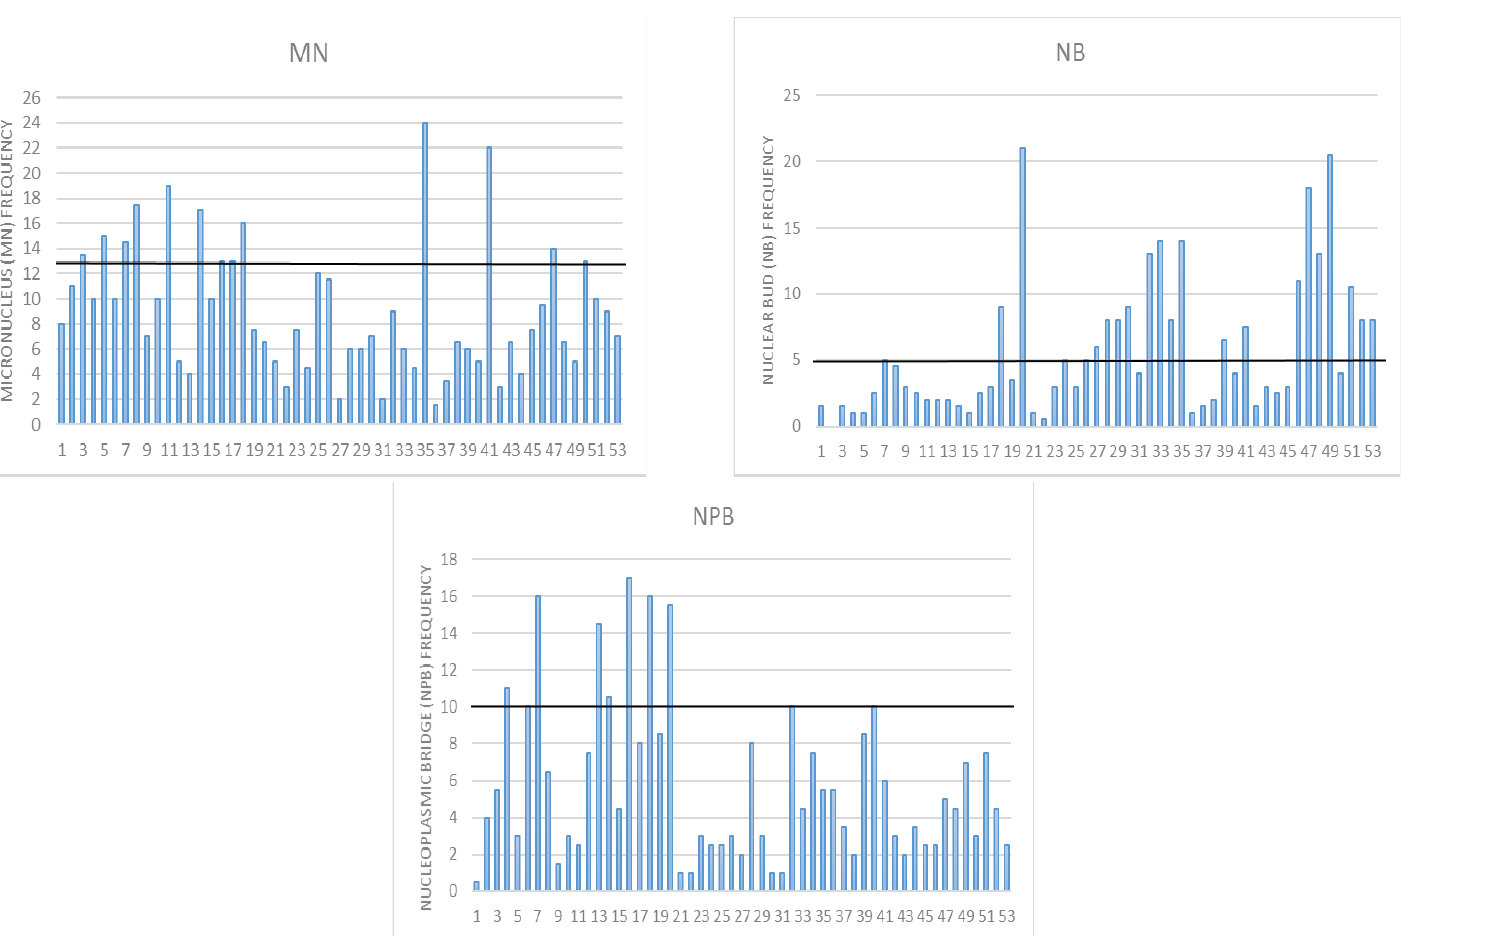
Figure 4. Individual DNA damage for micronucleus cytome assay parameters: MN-micronucleus with a reference range up to 12.5 per 1000 binucleated BN cells; NB—nuclear buds with a reference range up to 5 per 1000 BN; NPB—nucleoplasmic bridges with reference range up to 10 per 1000 BN cells in a healthy human population.